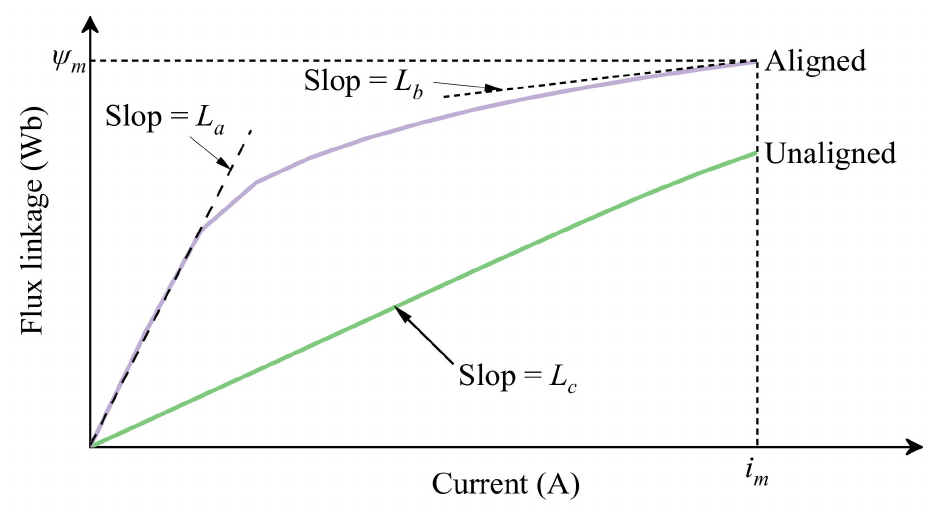
Figure 1. Magnetization